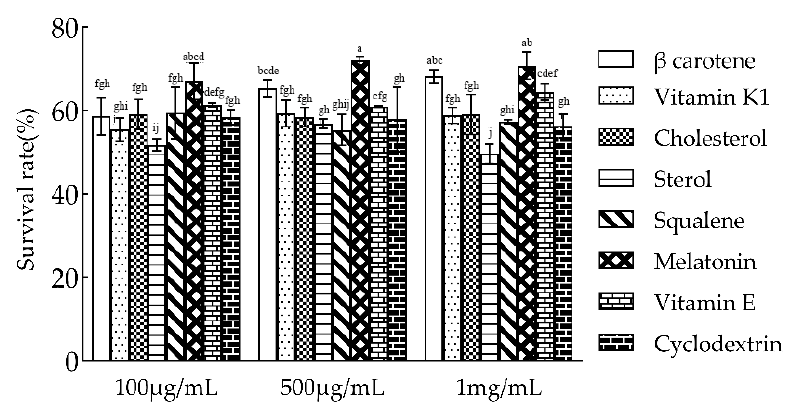
Figure 4. Effects of different concentrations of cell membrane regulators on the lyophilization survival rate of L. plantarum N8. Different letters indicate significant differences ( p < 0.05).